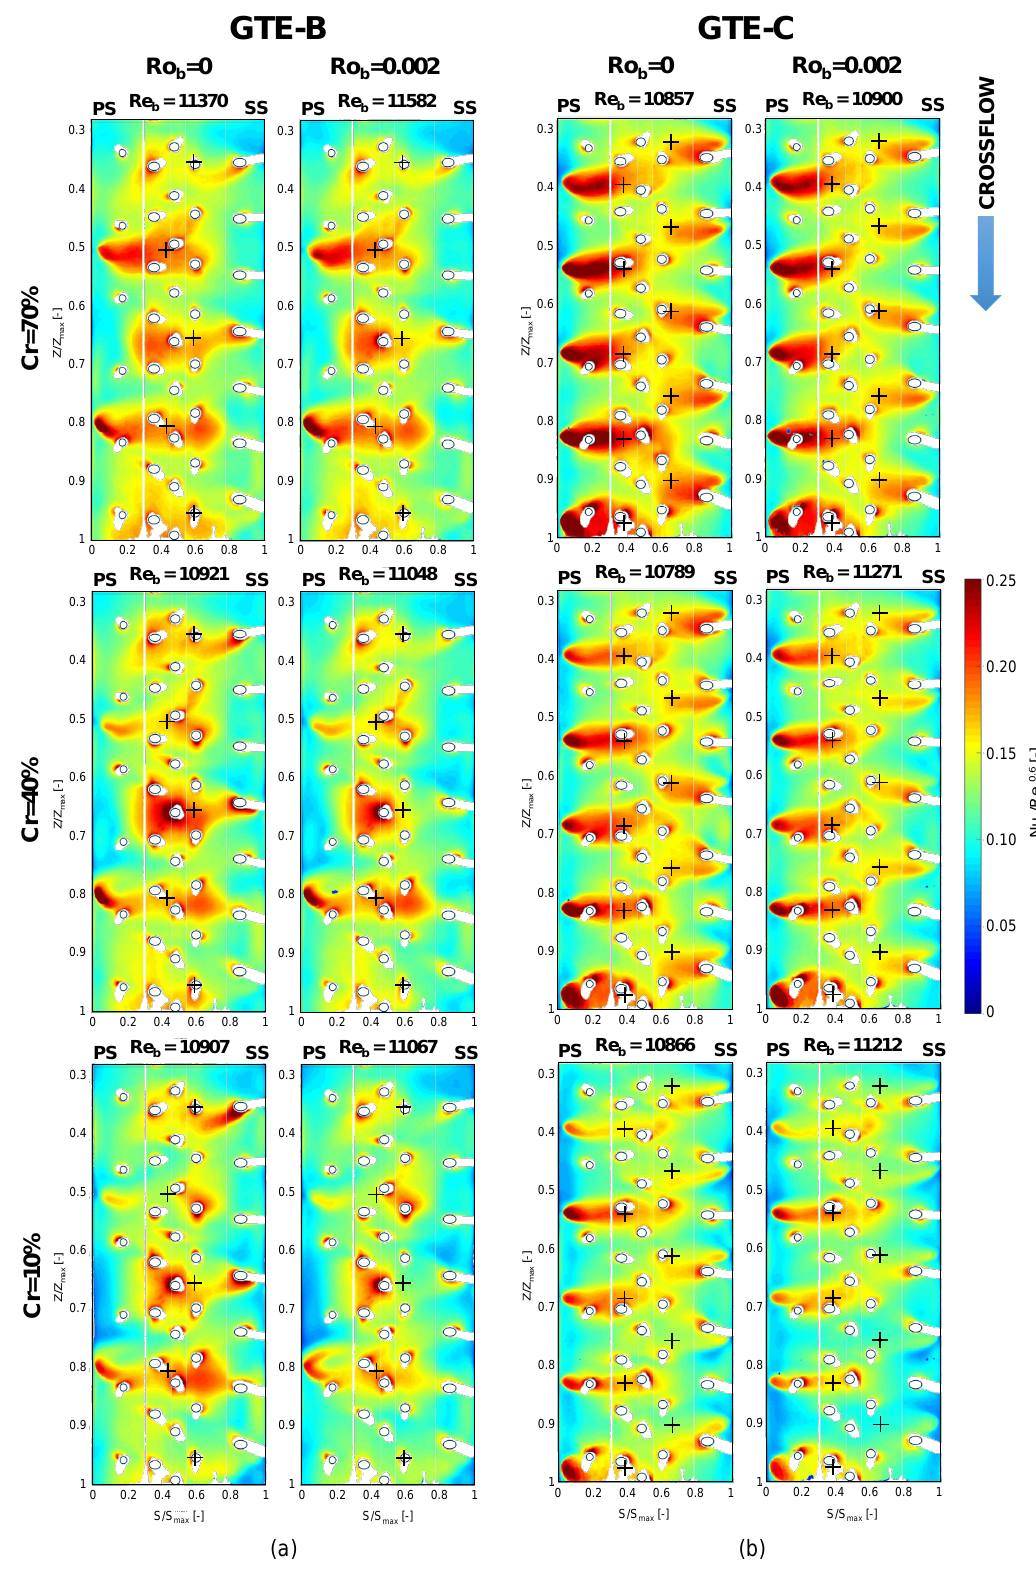
Figure 5. Nu b /Re b 0.6 distributions for Re b = 11,000 for ( a ) GTE-B and ( b ) GTE-C